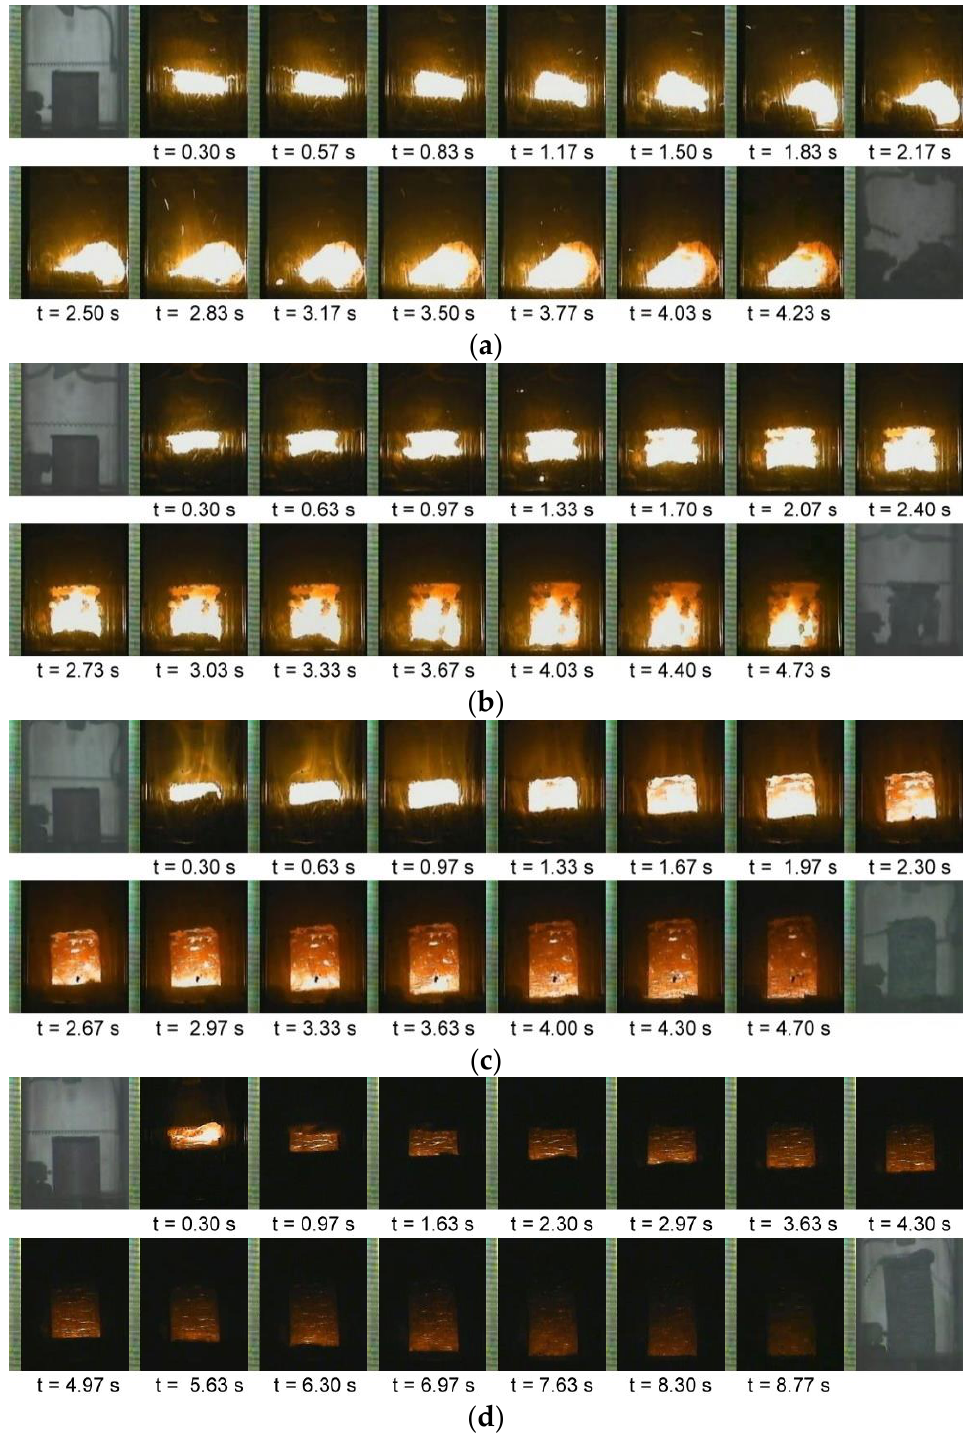
Figure 1. SHS combustion wave propagation sequences recorded from test samples of ( a ) Fe-25% Si, ( b ) Fe-40% Si, ( c ) Fe-50% Si, and ( d ) Fe-66.7% Si.